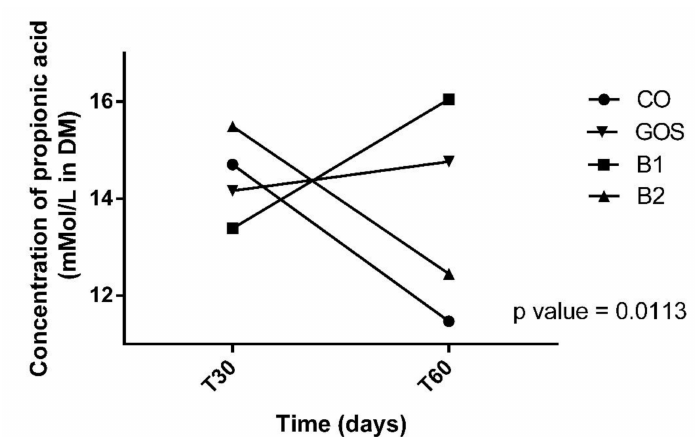
Figure 1. E ff ect of treatment x time interaction of propionic acid. CO: control food, without the addition of prebiotic; GOS: control food with addition of 0.38% galactooligosaccharides; B1: control food with addition of 0.5% YES GOLF ® prebiotic blend; B2: control food with the addition of 1% YES GOLF ® prebiotic blend; T30: 30-day period; T60: 60-day period.